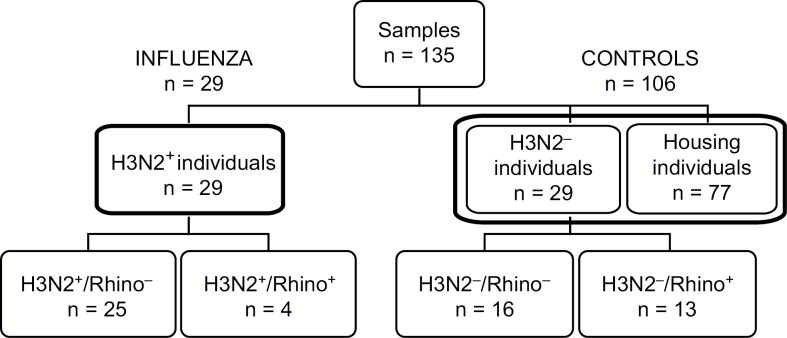
Sample selection. A total of 135 serum samples were tested; 58 sera were from individuals with febrile respiratory illness (FRI), 29 of whom tested positive by reverse transcription polymerase chain reaction (RT-PCR) for influenza A/H3N2. Of these H3N2+ cases, 25 were negative for other respiratory pathogens, while 4 were also positive for rhinovirus (Rhino+). Another 29 sera were from individuals with FRI who tested negative for influenza A/H3N2 by RT-PCR. Of these H3N2− individuals, 16 were negative for all other respiratory pathogens and 13 were Rhino+. The H3N2− (n = 29) and housing (n = 77) individuals were used as the control group (n = 106).